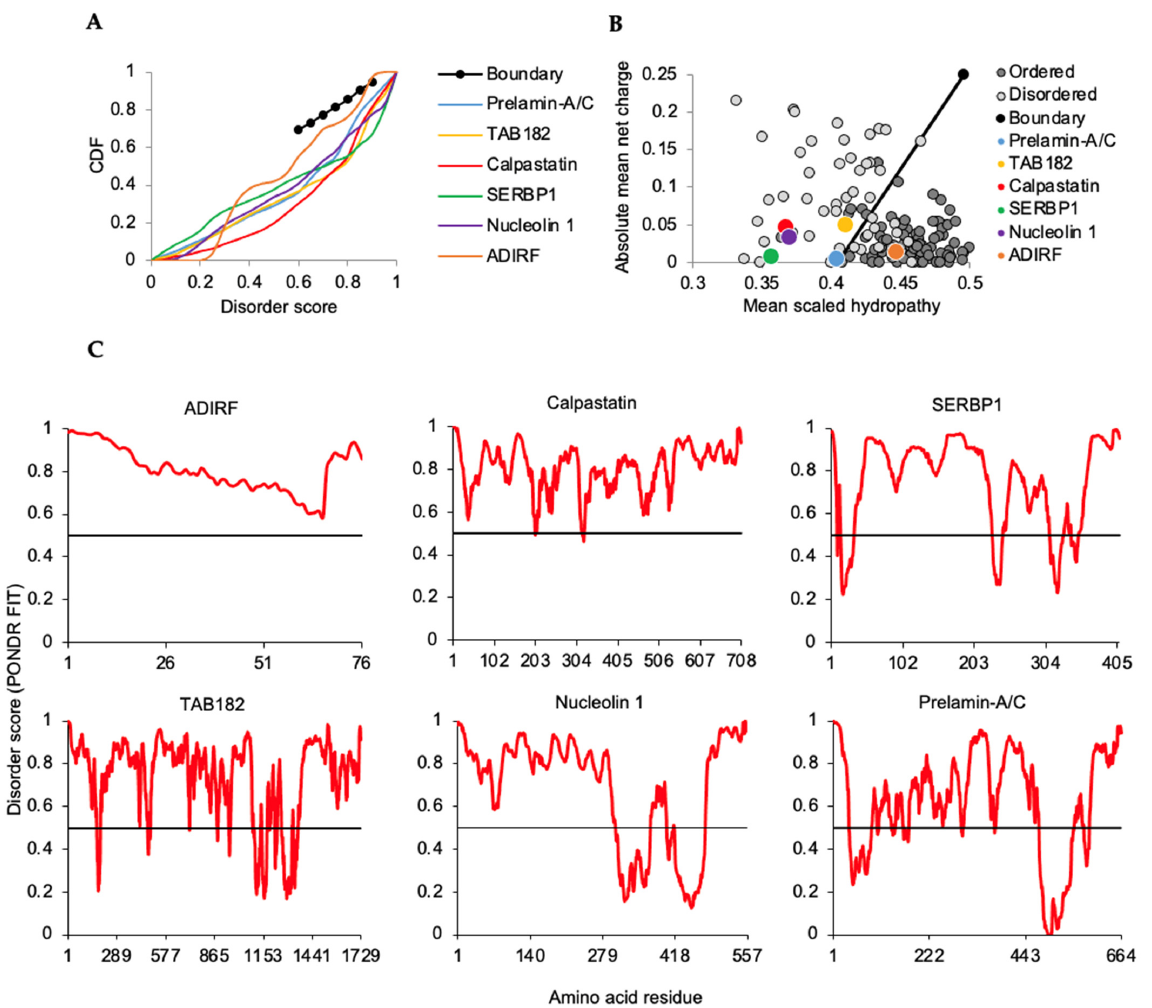
Figure 6. Intrinsic disorder analysis of broadly expressed proteins retrieved in KC thermostable lysate. ( A ) Cumulative distribution function (CDF). ( B ) Charge-hydropathy boundary (black line) shows separation trend for database disordered with thermostable proteins overlapping reference set disorder. ( C ) PONDR-FIT analysis. y -axis values ≥ 0.5 reference value (black line) are in disordered regions. ADIRF, adipogenesis regulatory factor. SERBP1, plasminogen activator inhibitor 1 RNA-binding protein. TAB182, 182 kDa tankyrase-1-binding protein.